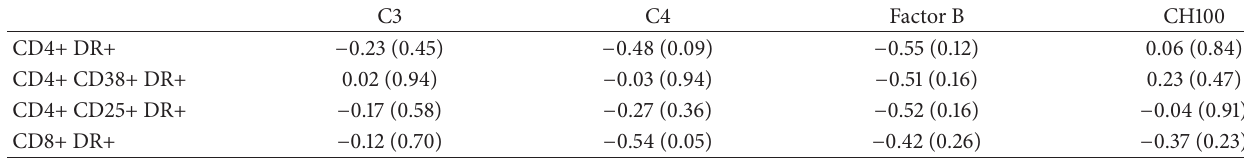
Table 4: Bivariate correlation between complement levels and lymphocyte subsets in thrombotic APS patients.